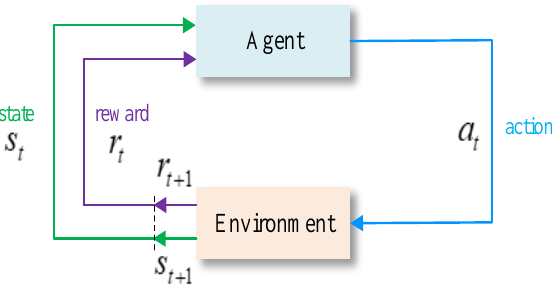
Figure 2. The agent–environment MDP interaction